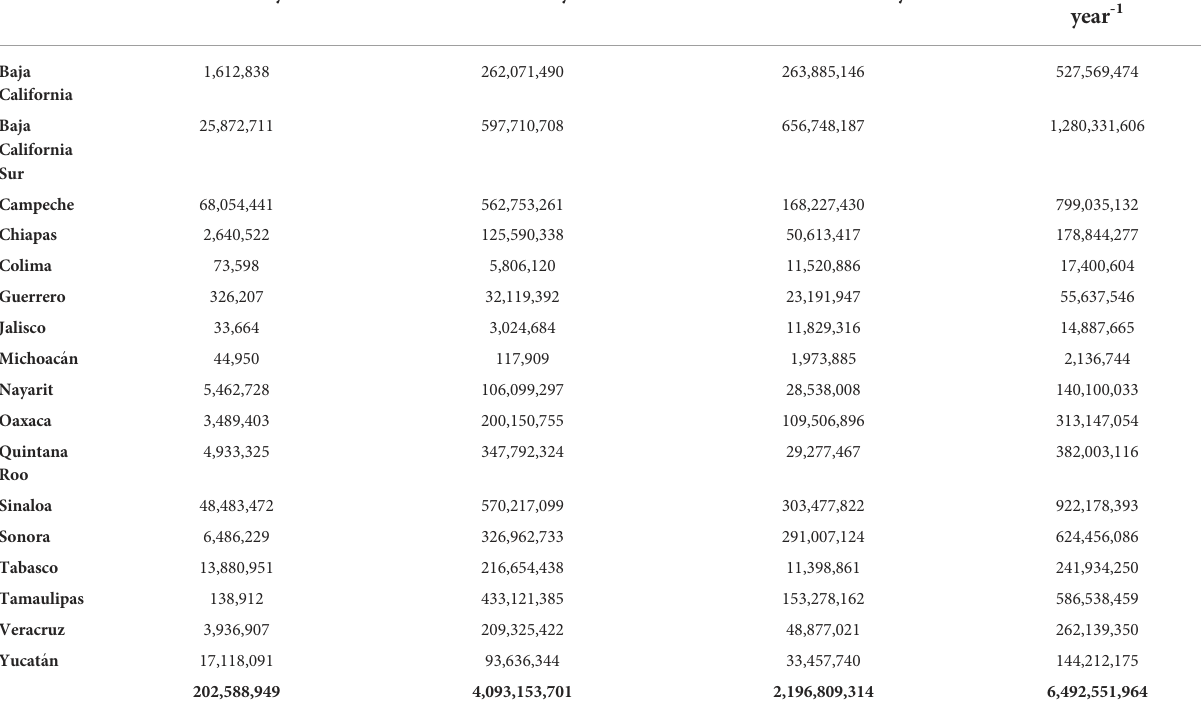
TABLE 4 Estimated total cost caused by potential ecosystem services losses for each coastal state in